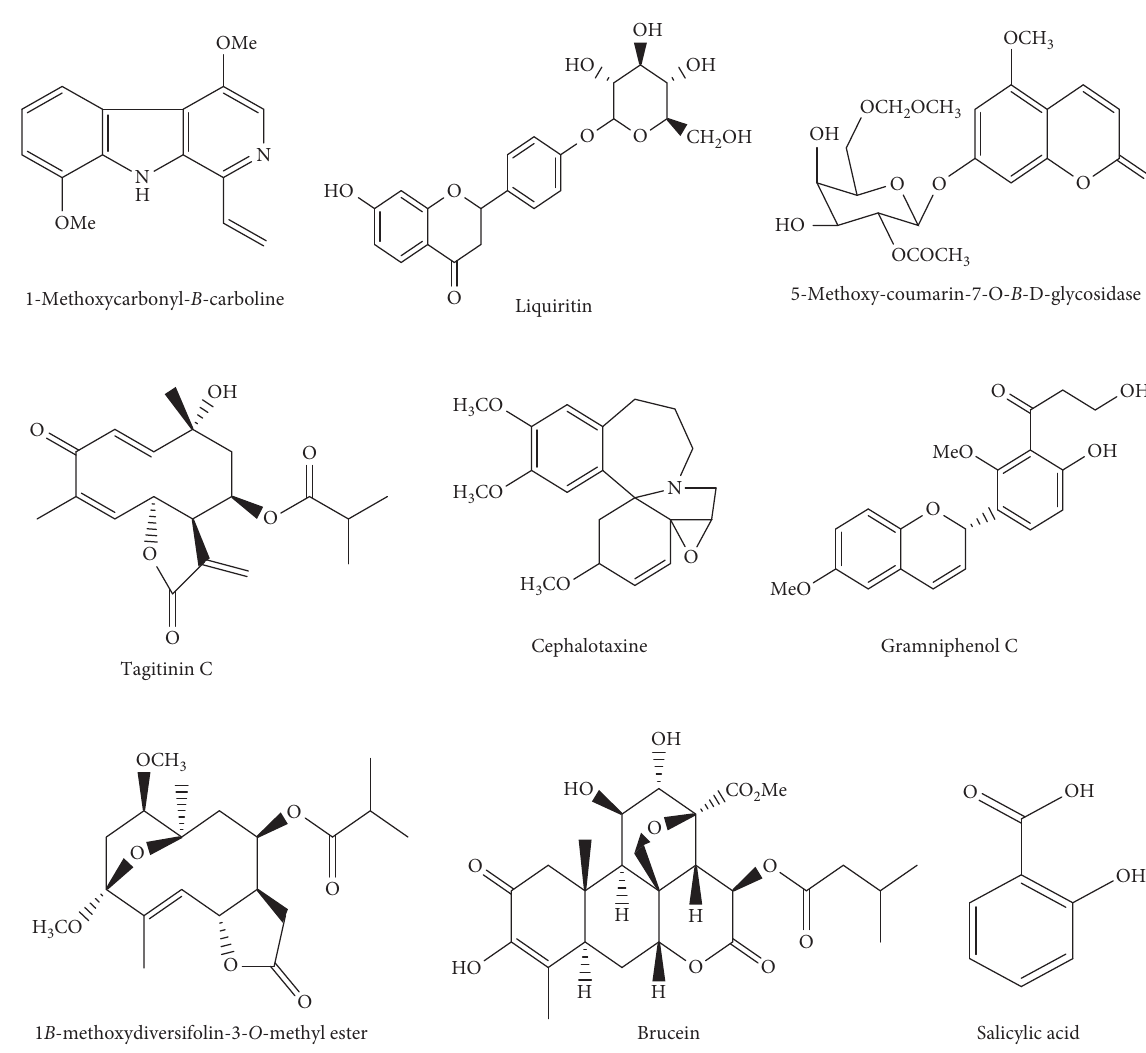
Figure 4: Natural virucidal